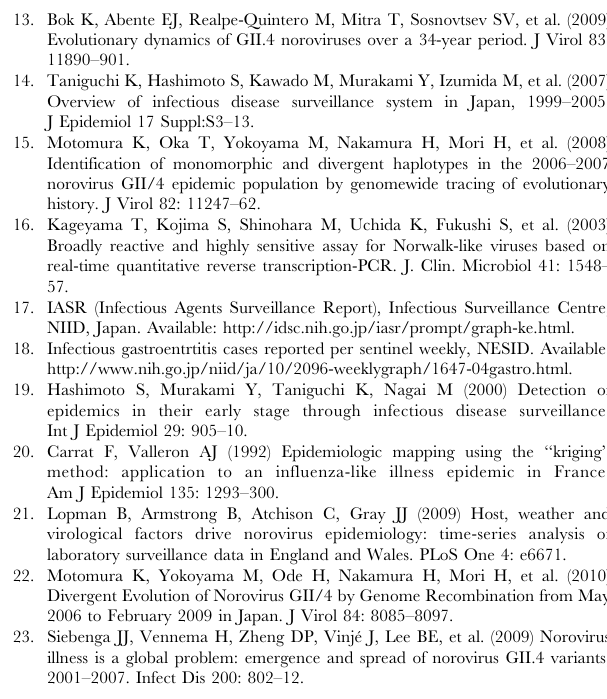
Figure S1 Monthly averages (2006 -2009) of daily maximum temperature (A) and relative humidity (B) in Hokkaido (North area), Tokyo (Middle area), and Fukuoka (South area). Data were obtained from Japan Meteorological Agency (http://www.data.jma.go.jp/obd/stats/